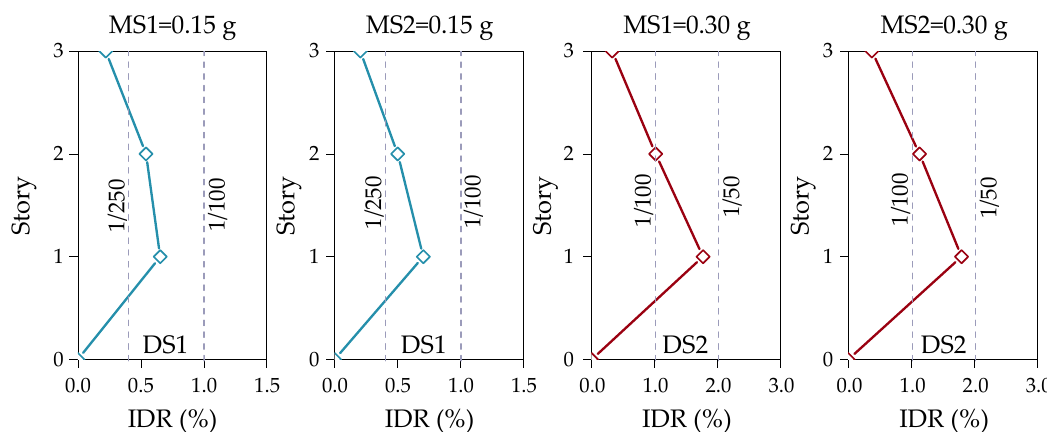
Figure 5. IDR distribution and damage limitation value under MS1 and MS2 mainshock excitation. Table 5 lists the natural frequencies of the intact RC frame and four MD-RC frames.